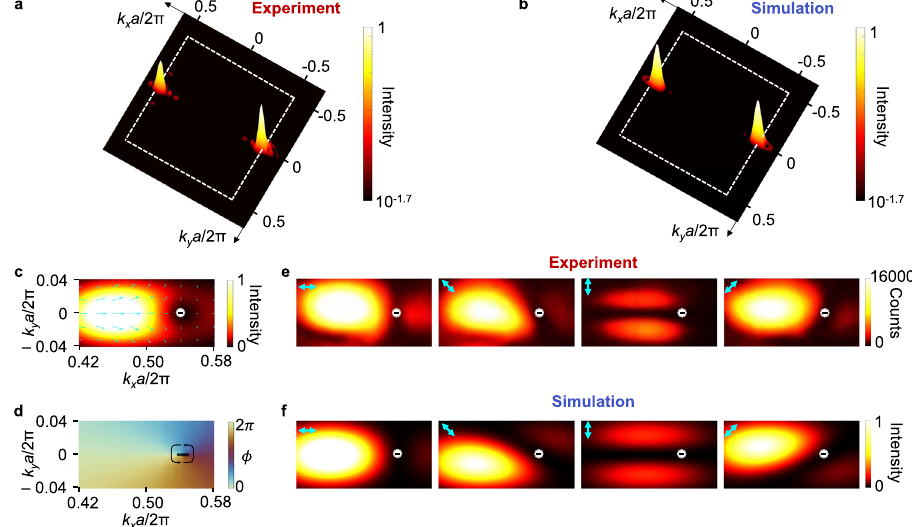
Fig.3|Directimagingpolarizationsingularitiesatlasingstate.a Lasingemission pattern in momentum space. Two polarization singularities from the lasing mode appear as dark holes, and each of them has a paired radiation channel appearing as bright peak. b Three-dimensional full wave simulated lasing emission pattern in momentum space. The dashed squares in a , b indicate the boundary of the fi rst Brillouin zone. c Simulated emission pattern superimposed with local polarization